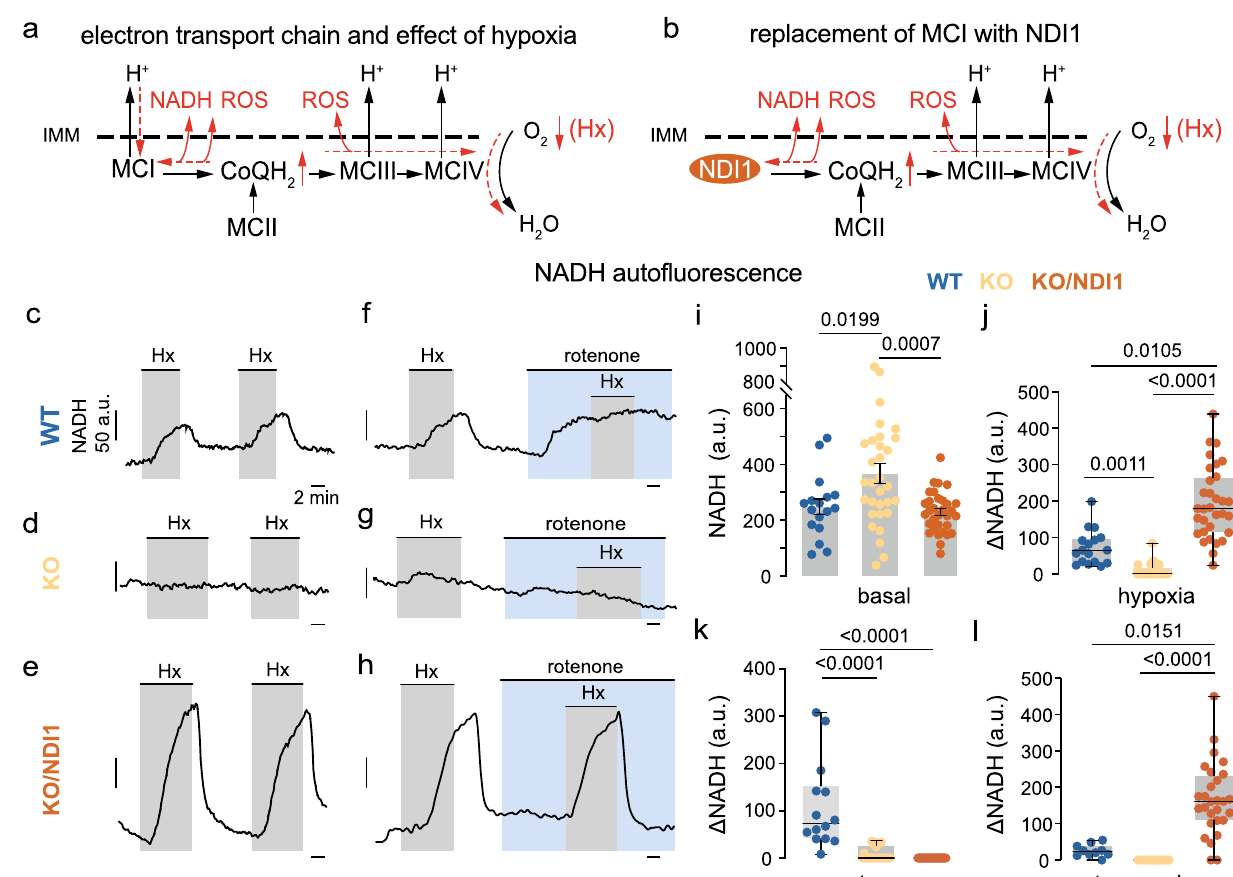
Fig. 4 | Mitochondrial NADH and hypoxia signaling in complex I-de fi cient and NDI1-expressing glomus cells. a Scheme representing the electron transport chain(ETC)inglomuscellsanditsdynamicchangesinresponsetohypoxia(Hx,red lines and symbols). IMM, inner mitochondrial membrane. b Scheme representing the ETC of glomus cells in which MCI is replaced with NDI1. Dynamic changes in hypoxia are represented by red lines and symbols. c – e , Representative recordings of changes in NADH auto fl uorescence recorded in response to hypoxia (Hx, PO 2 ~15mmHg) in dispersed glomus cells from WT ( c ), KO ( d ) and KO/NDI1 ( e ) mice. Calibration bars as indicated in ( c ). f – h Micro fl uorimetric recordings illustrating changes in NADH induced by hypoxia (Hx),rotenone (1 μ M)and the application of hypoxia in the presence of rotenone in dispersed glomus cells from WT ( f ) KO ( g ) and KO/NDI1 ( h ) mice. Calibration bars as indicated in ( c ). i Average basal levels of NADH (in arbitrary units, a.u) recorded in glomus cells from WT mice (254±28,